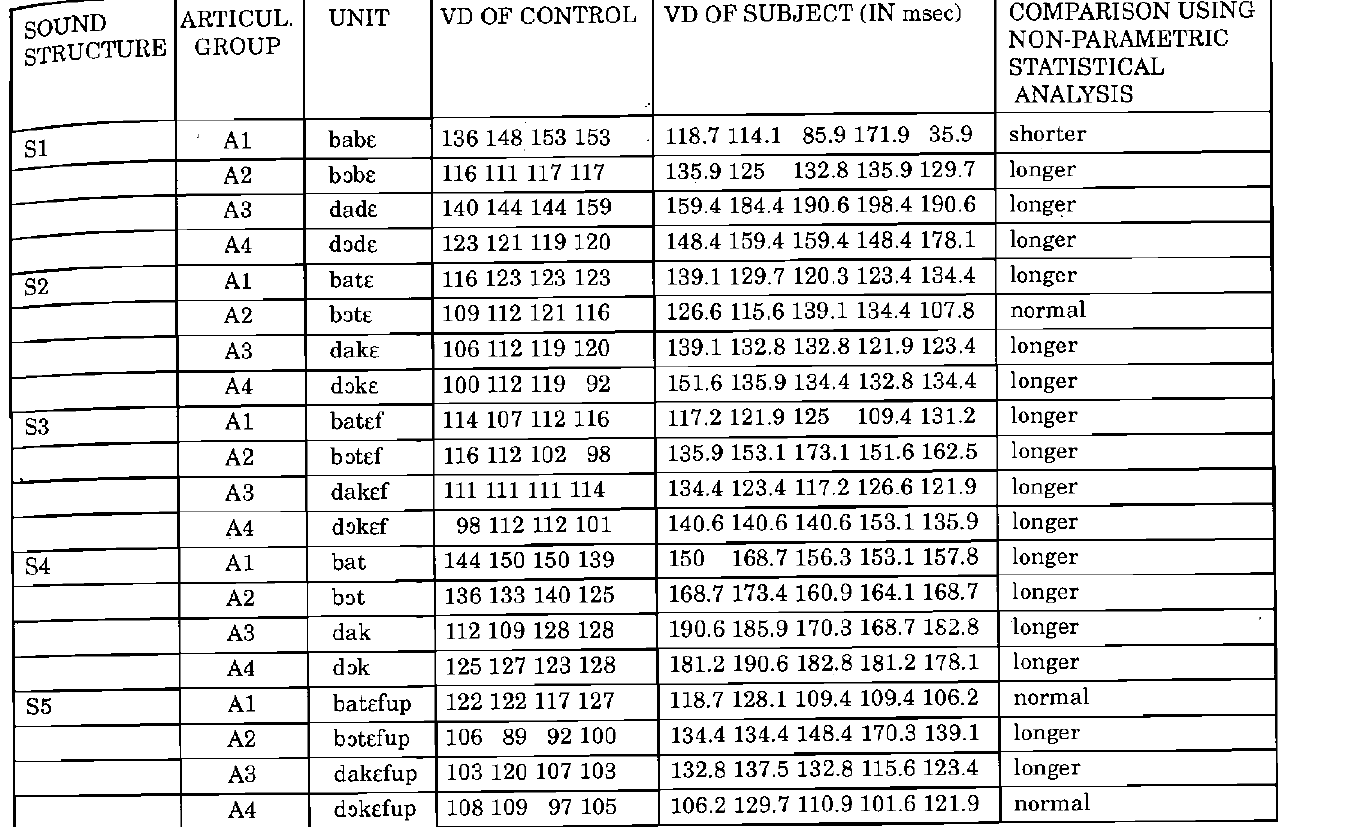
TABLE 5: Utterance duration results with contextual factors sound structure and articulation characteris- tics indicated . SOUND STRUCTURE